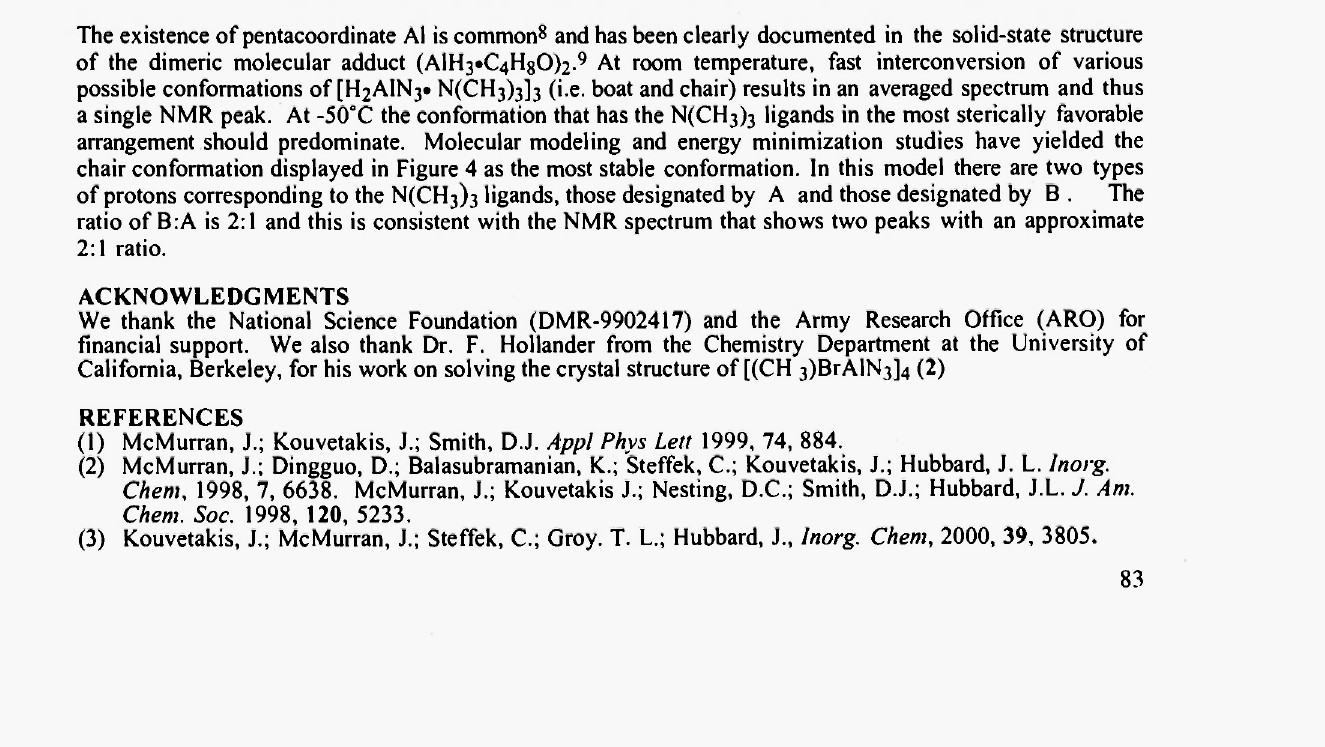
A Figure 4. Molecular model of a trimeric [(H2A1N3¥N(CH3)3]3 compound with chair-like conformation showing two kinds of CH3 protons designated as (A) and (B) respectively. The Al sites are five-coordinate and the horizontal bars at the Ν sites represent the bridging azide